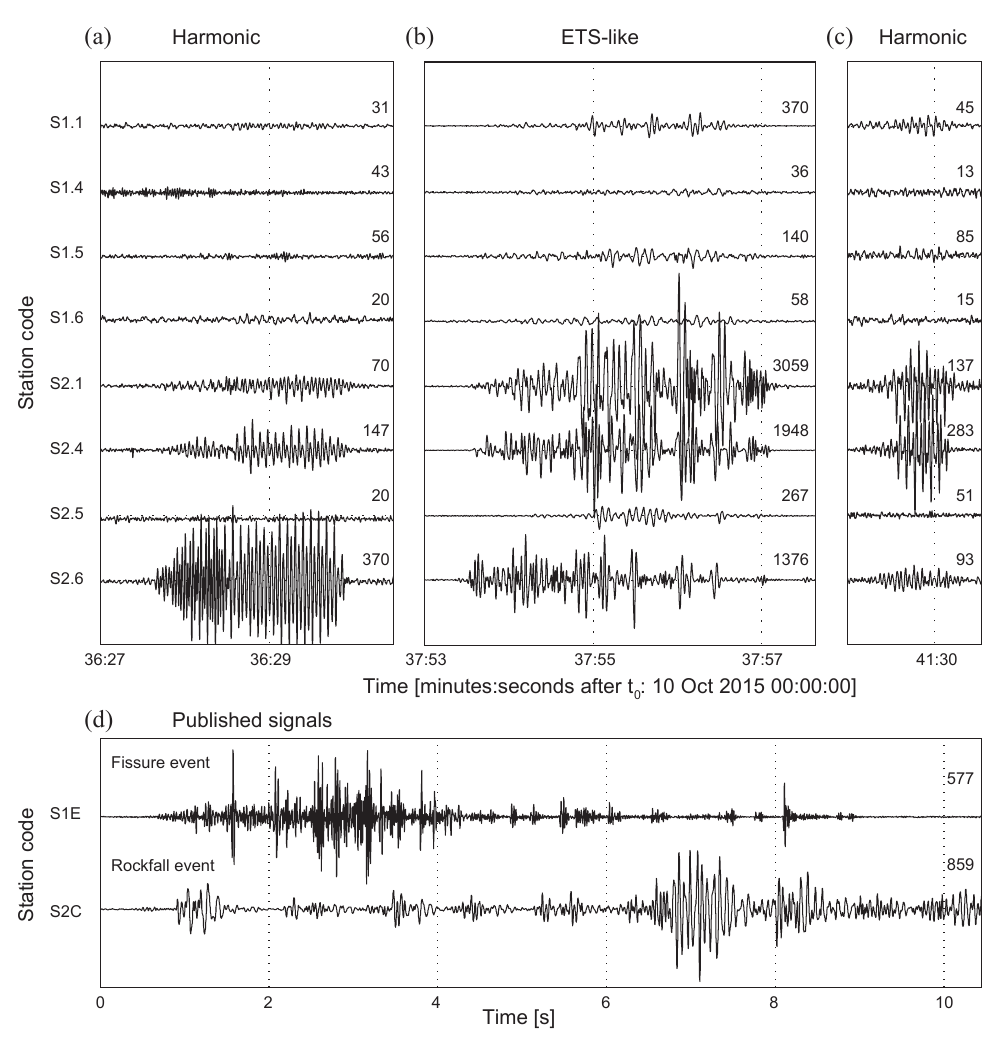
Figure 5. (a–c) Vertical trace seismograms featuring selected signals of a 40min long tremor sequence recorded 10 October 2015 between 00:35 and 01:15 at PG15 (see station nomenclature in Fig. 1). Waveforms are normalized to the highest amplitude trace of individual events and maximum absolute zero-to-peak amplitudes are given in nanometers per second on top of each seismogram. Event (a) and (c) are harmonic tremors, event (b) corresponds to an ETS-like event. Note the prominent attenuation of the waveforms and the relatively lower amplitudes of harmonic tremors. (d) Signals published in Walter et al. (2012) and interpreted as a fissure event (top, t 0 14 July 2008, 23:48:40) and a rockfall event (bottom, t 0 14 July 2008, 23:49:04). Waveforms are plotted using the same timescale as in (a) – (c) to facilitate the signal